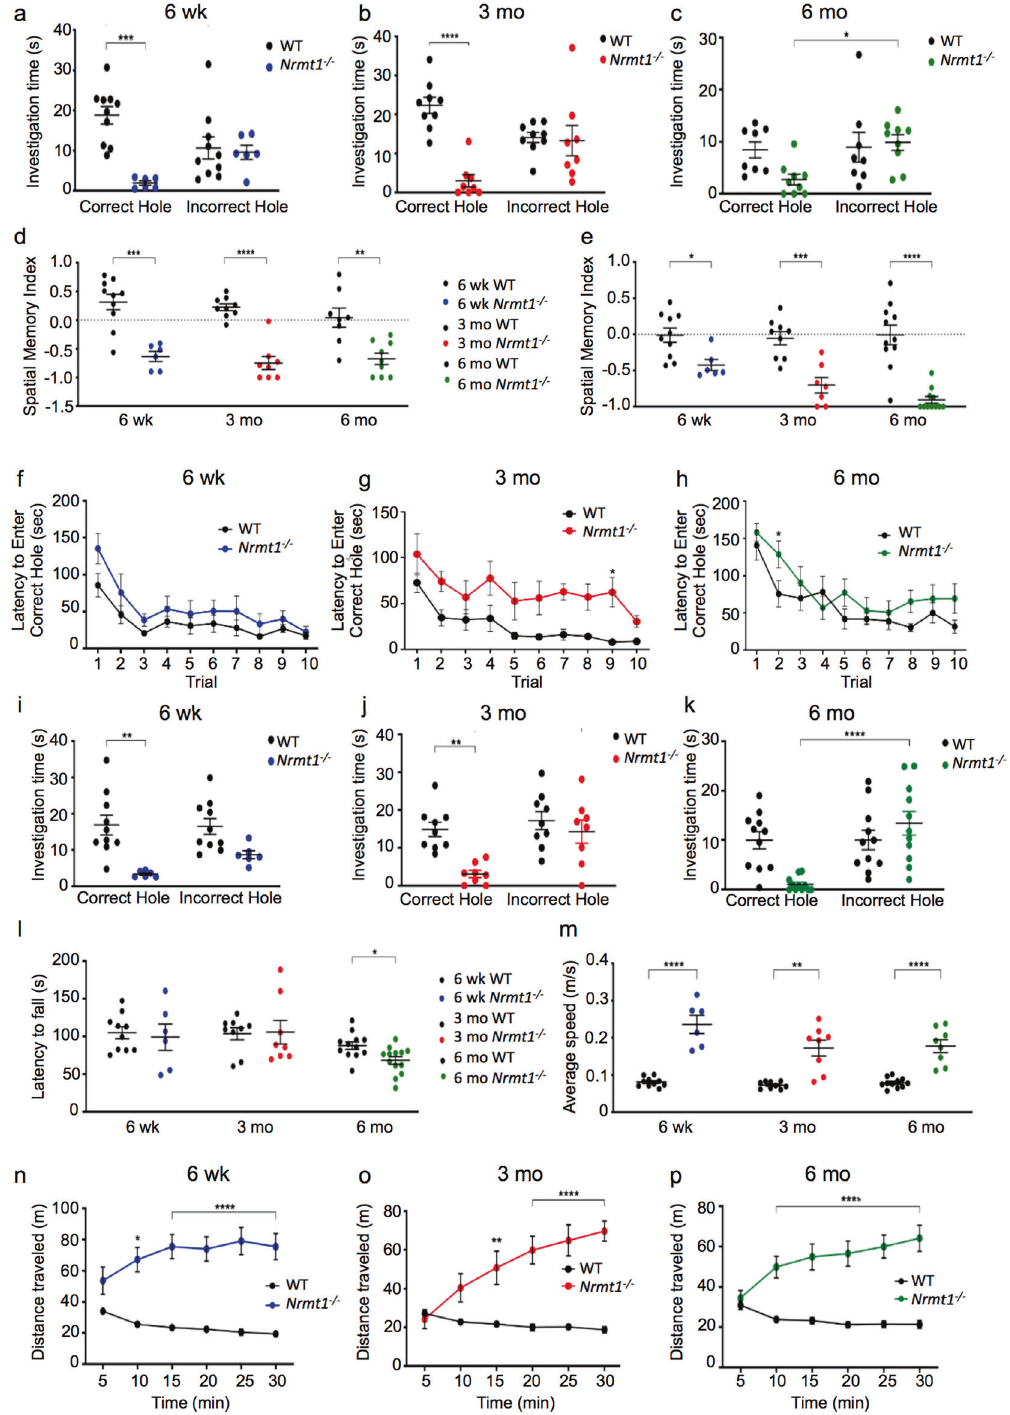
Fig. 3 Nrmt1 − / − mice exhibit short- and long-term memory impairment and hyperactivity. Two-trial Barnes maze spatial memory tasks show that Nrmt1 − / − mice spend signi fi cantly less time exploring the correct hole than WT mice at a 6 weeks and b 3 months. c At 6 months, Nrmt1 − / − mice spend signi fi cantly more time at the incorrect holes. d The spatial memory indexes (SMI) calculated from the two-trial tasks indicate short-term memory loss at all three ages. SMI = (time exploring correct hole − time exploring incorrect holes)/(total exploration time). e The SMIs calculated from the ten-trial tasks also indicate long-term memory loss at all three ages. Although Nrmt1 − / − mice are able to learn the correct hole when given ten training trials at f 6 weeks, g 3 months, and h 6 months, the ten-trial Barnes maze also shows Nrmt1 − / − mice spend signi fi cantly less time exploring the correct hole at i 6 weeks and j 3 months, and signi fi cantly more time at incorrect holes at k 6 months. l Rotarod assays show a small motor impairment in Nrmt1 − / − mice at 6 months. Open- fi eld assays show Nrmt1 − / − mice travel at m higher average speeds for n – p longer distances than WT mice. * p < 0.05, ** p < 0.005, *** p < 0.0005, and **** p < 0.0001 as determined by a – c , i – k two-way ANOVA or d – h , l – p unpaired t -test, n = 6 – 10. Error bars represent mean ±